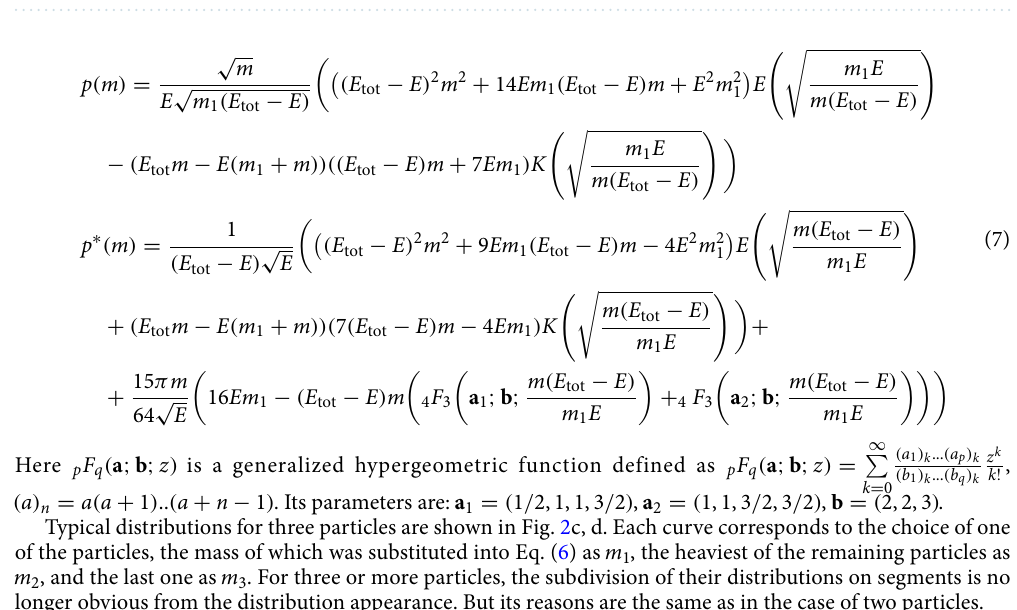
( 2, 3, 5, 8 ) ideal gas particles with masses m in a round vessel. They are Figure 2. Energy distributions for N = obviously different for different mass particles, contrary to the Boltzmann distribution. The continuous curves show theoretical distributions according to ( a ) Eq. (5), ( c , d ) Eq. (6) and ( e , f ) Eq. (3), the dots show the results of the numerical experiments. The vertical dotted lines indicate the distribution segments boundaries. The radii 2 and R 10 40 ), except for the case ( b ) where r i of all particles were small compared to the vessel size ( r i = = = 30 . For big enough particles, their size affects the energy distribution, the theoretical distributions and R = with and without (Eq. (5) by dotted line) the particle size amendment are shown. As the number of particles increases, the typical energy distribution approaches the Boltzmann one, shown by the dotted lines. The deviations from it correlate with the particle mass, the distributions of light particles pass below the Boltzmann E tot one at E (cid:31) N and above it